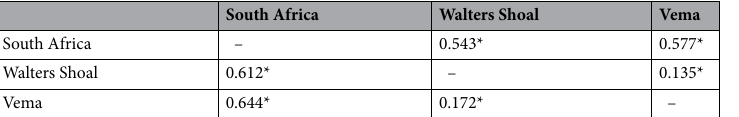
Table 2. Pairwise G” ST (999 permutations; below diagonal) and D EST (999 permutations; above diagonal) values for the SA, Vema and Walters Shoal Seriola lalandi populations. *Significant p- values ( p < 0.05) after Bonferroni